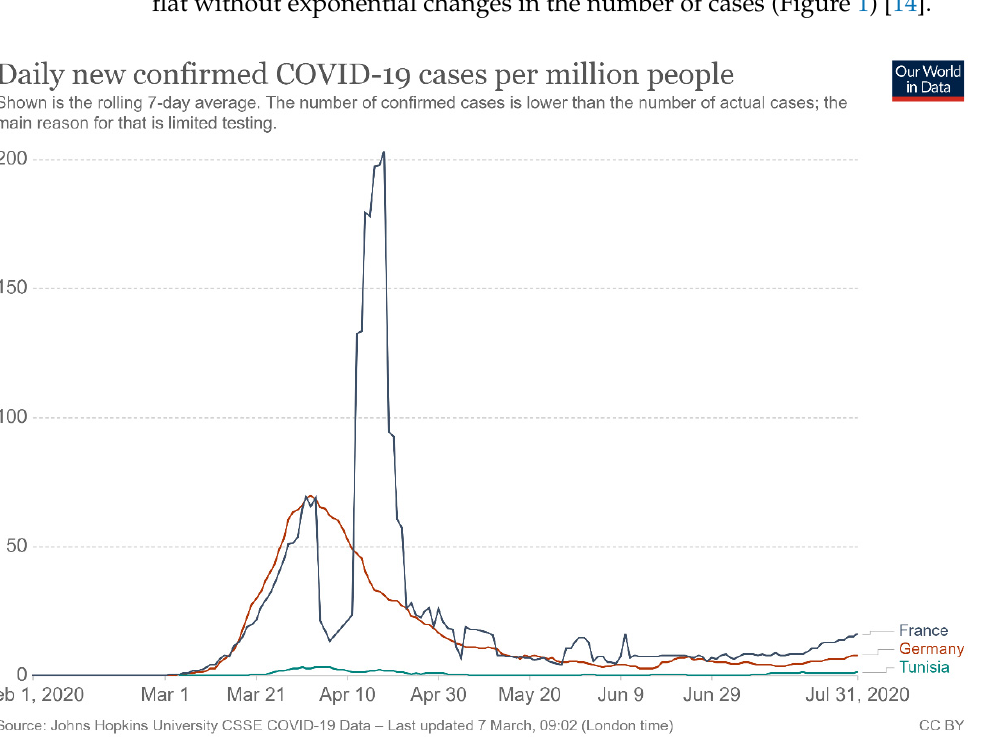
Figure 1. Shown is the rolling 7-day average of coronavirus cases in France, Germany, and Tunisia from 1 February 2020 to 31 July 2020. Source: Max Roser HR, Esteban Ortiz-Ospina, Joe Hasell. Posted online on OurWorldInData.org, 30 January